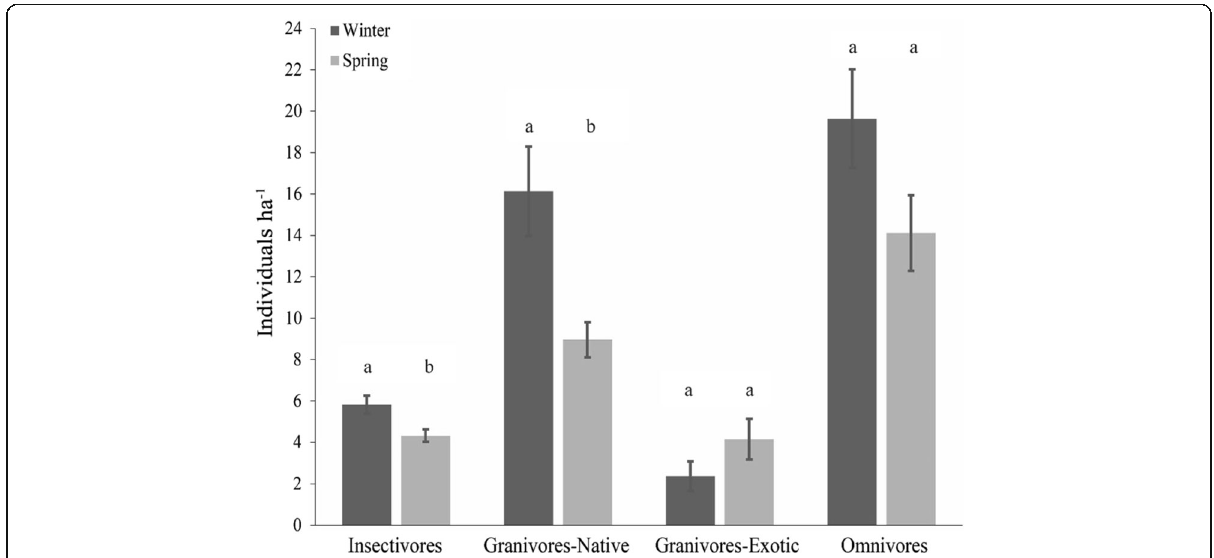
Fig. 3 Abundance (± SE) between diet groups between seasons ( N = 111 plot stations). Different letters represent significant differences among each group. Number of species for winter and spring were, respectively, insectivores 6 and 5, granivores-native 7 and 6, granivores-exotic 3 and 3 and omnivores 6 and